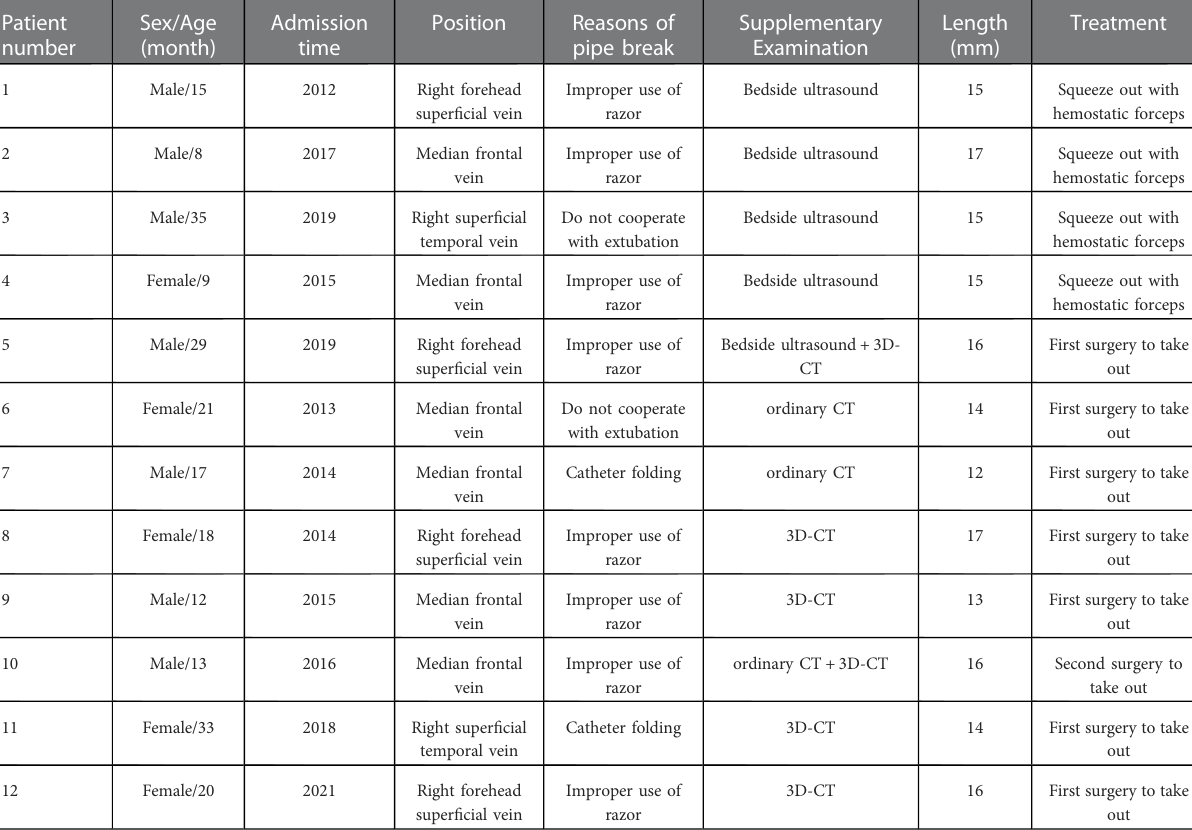
TABLE 1 Information of 12 patients with rupture of scalp venous indwelling needle